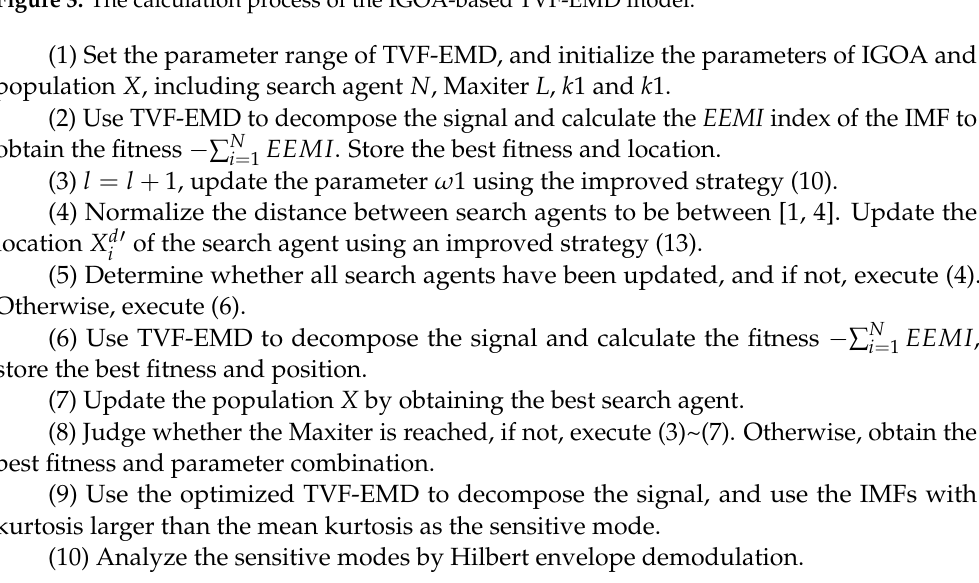
Figure 3. The calculation process of the IGOA-based TVF-EMD model.